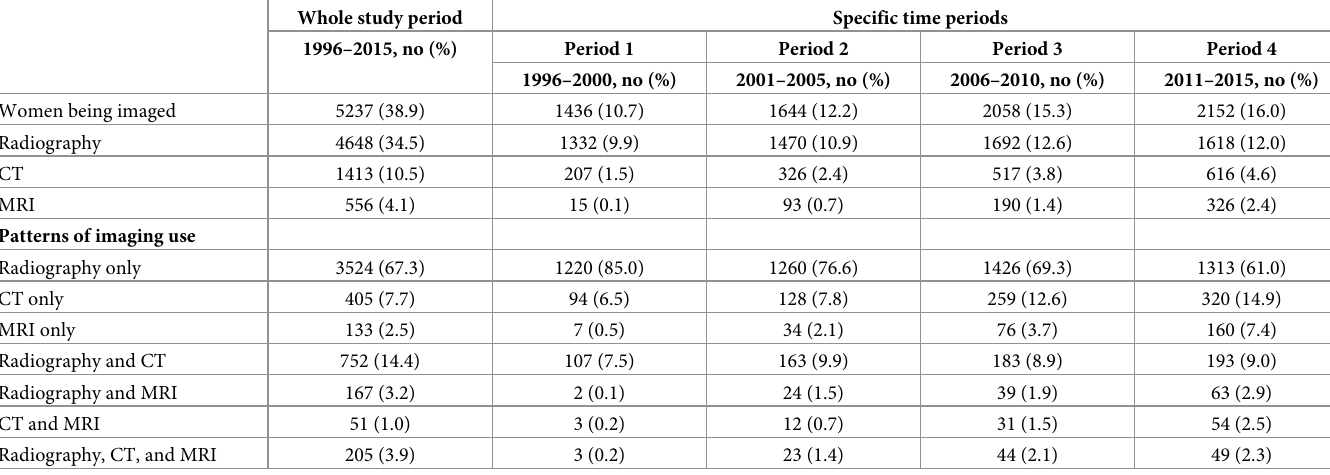
Table 2. Use of lumbar spine imaging from 1996 to